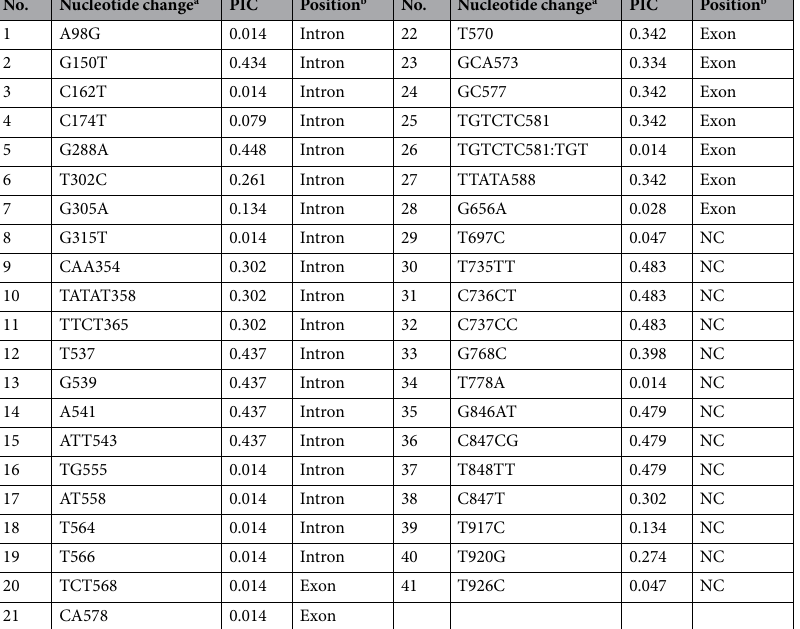
Table 1. Polymorphism information content (PIC) values and positions in the gene for nucleotide polymorphisms in HvP5CS1 . a The first letter indicates wild type nucleotide at mutation site from the